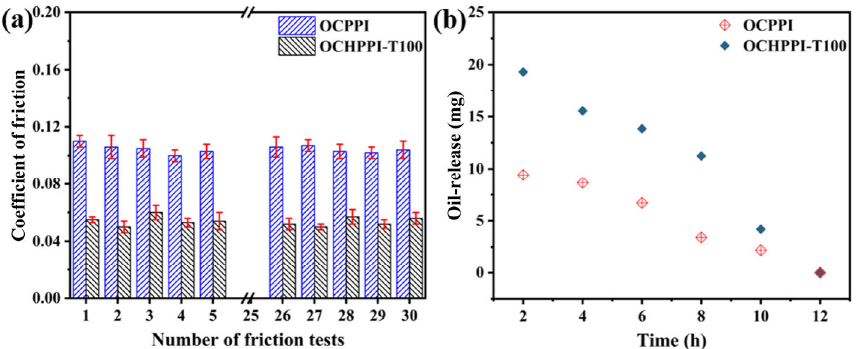
Fig. 15 (a) COF from the first to the 30th time (load = 10 N, frequency = 5 Hz, and the frictional test lasted 60 min) for OCPPI-T100 and OCPPI and (b) the maximum oil release for OCPPI-T100 and